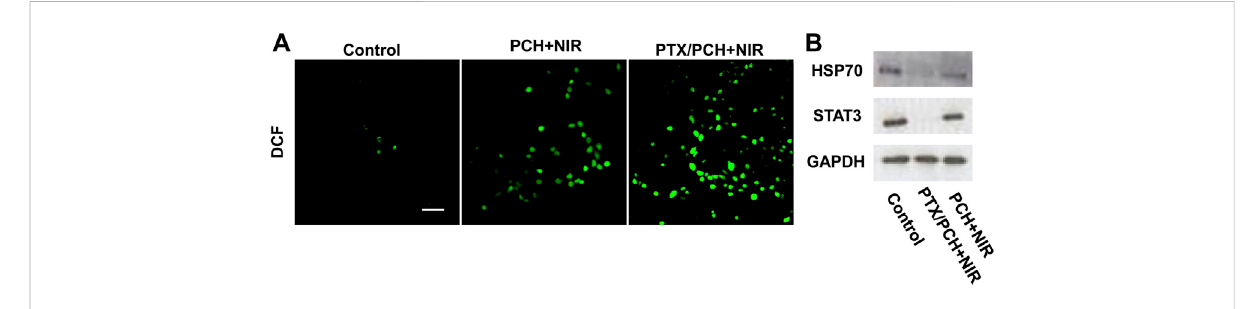
FIGURE 4 (A) ROS production detection after distinct treatments. (B) HSP70 and STAT3 expression evaluation. Scare bar = 50 μ